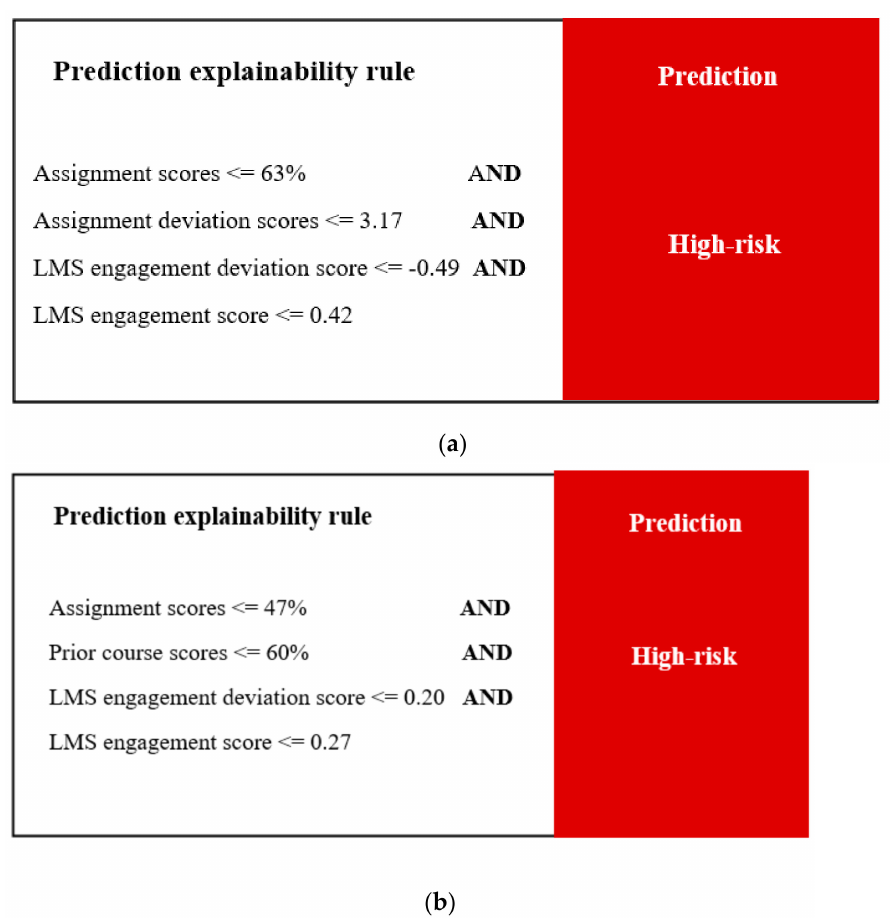
Figure 5. ( a ) Anchor explanation for Student A. ( b ) Anchor explanation for Student